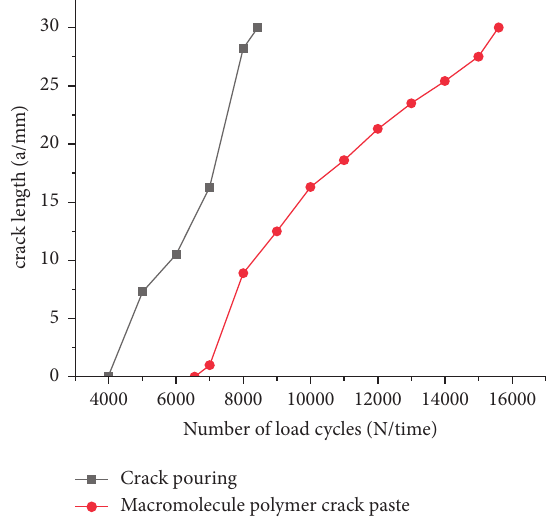
Figure 3: N - a curve under common grouting and crack paste resistance treatment